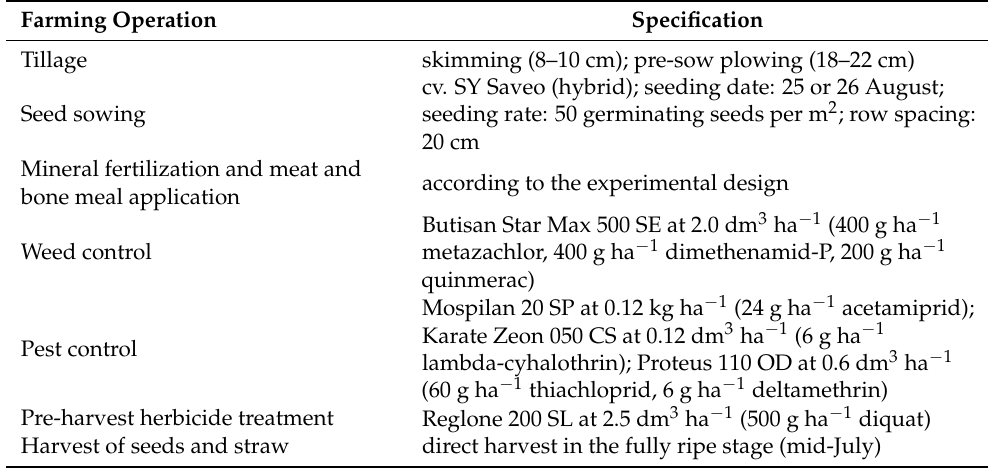
Table 1. Production technology of winter oilseed